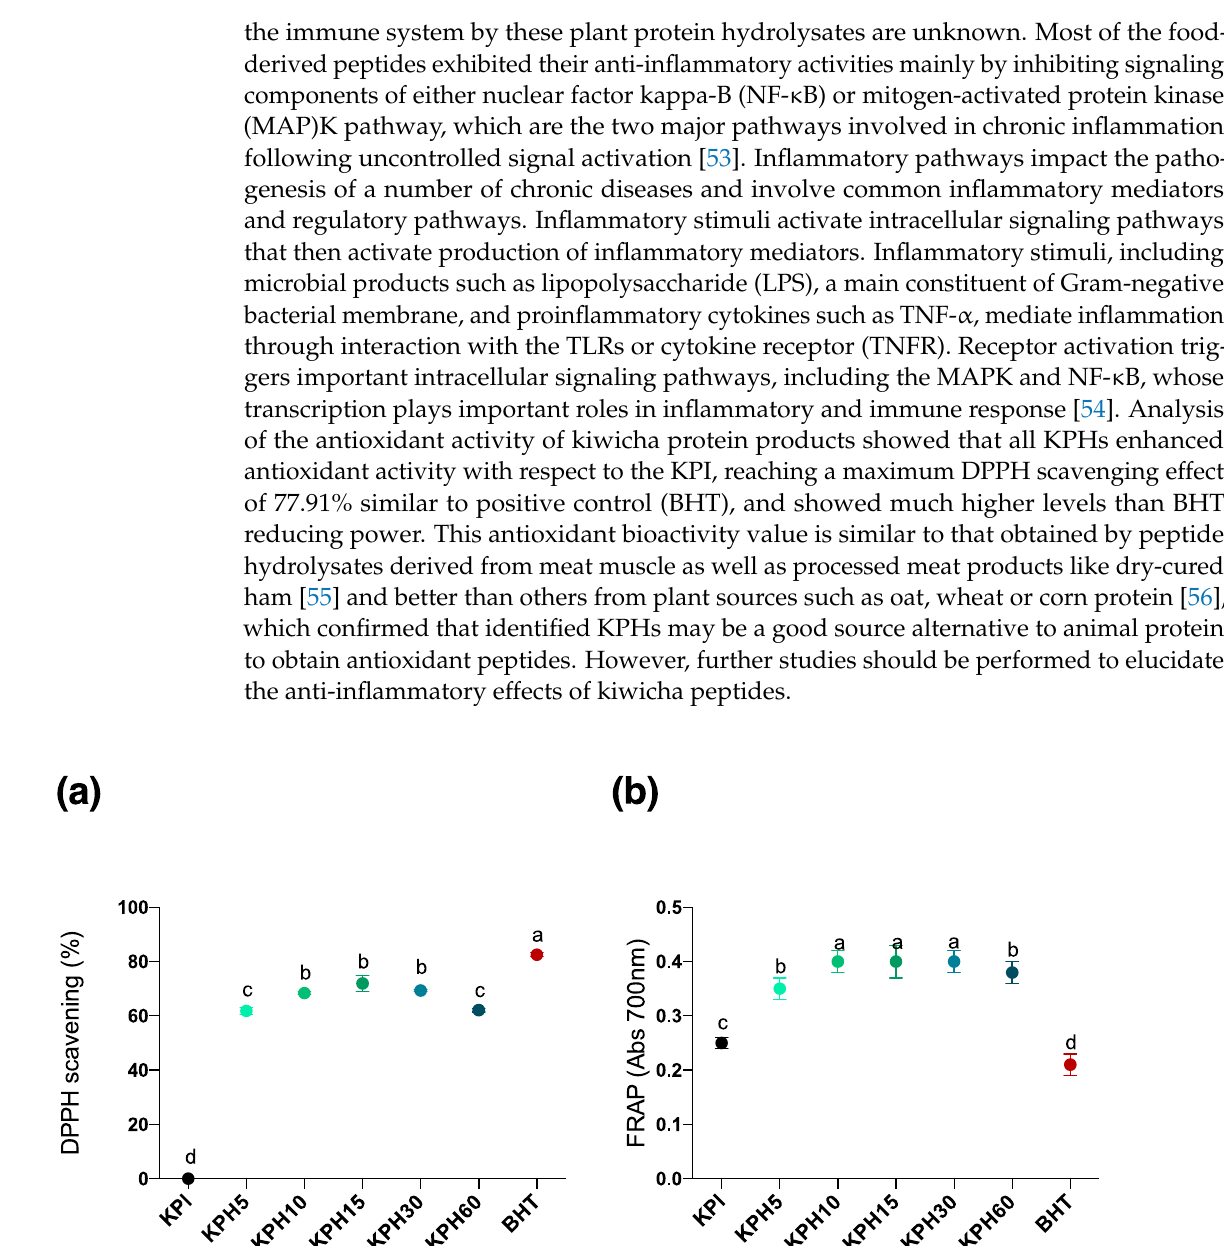
Figure 2. Molecular weight (MW) profiles by FPLC (size-exclusion) chromatogram of KPI and KPH5, KPH10, KPH15, KPH30, and KPH60. MW ranging from 1 to 300 kDa.